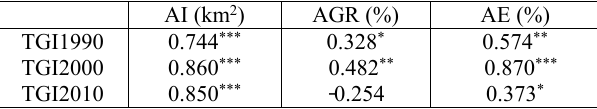
Table 6. Correlation analysis result between TGI and construction land expansion indicators